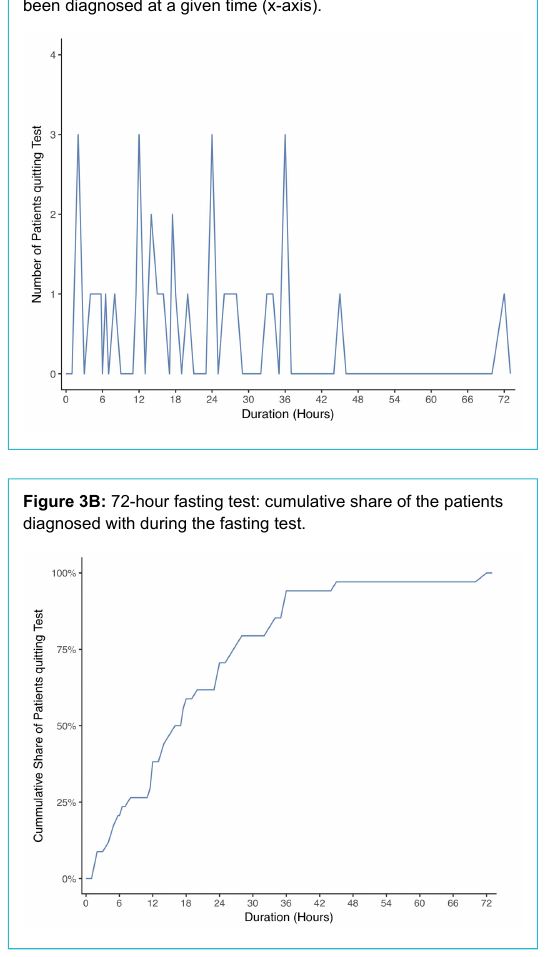
Figure 3A: 72-hour fasting test: distribution of the time until the end of fasting. On the y-Axis the number of patients which had been diagnosed at a given time (x-axis).